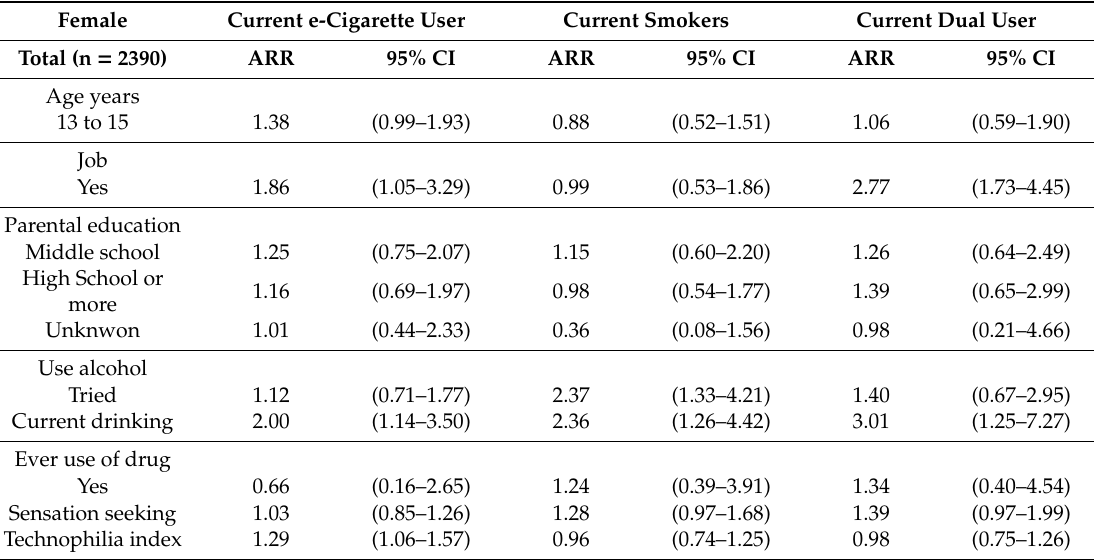
Table A1. Sensitivity analyses among